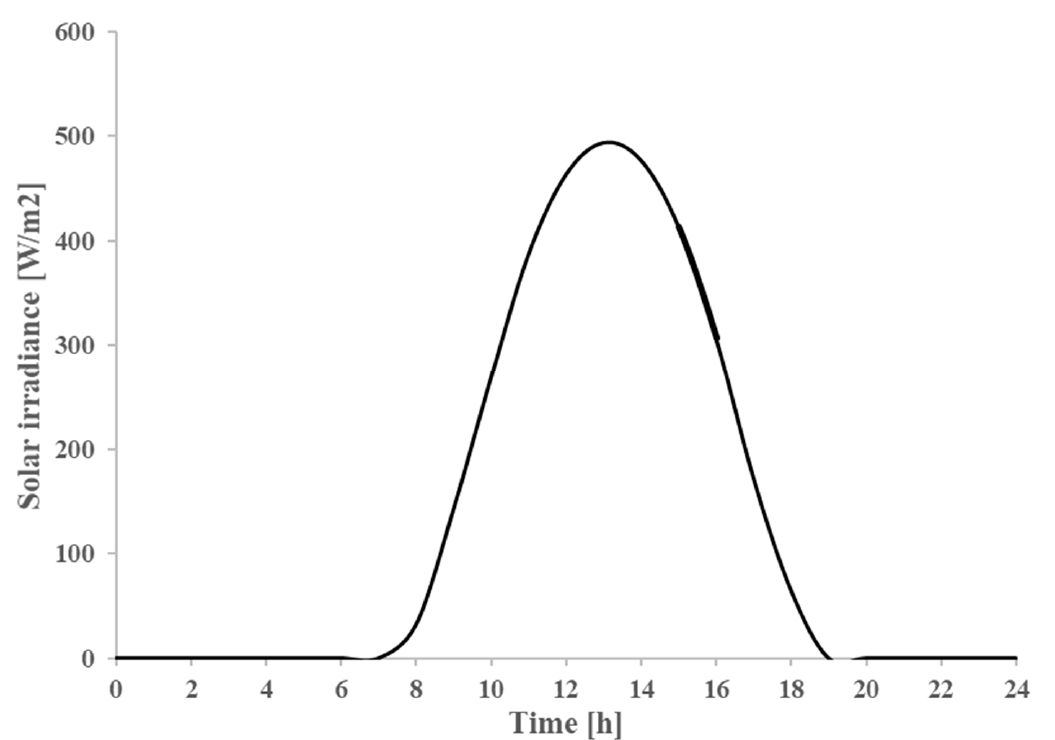
Figure 10. Solar irradiance (clear-sky radiation) at various times during the day on 17 January.